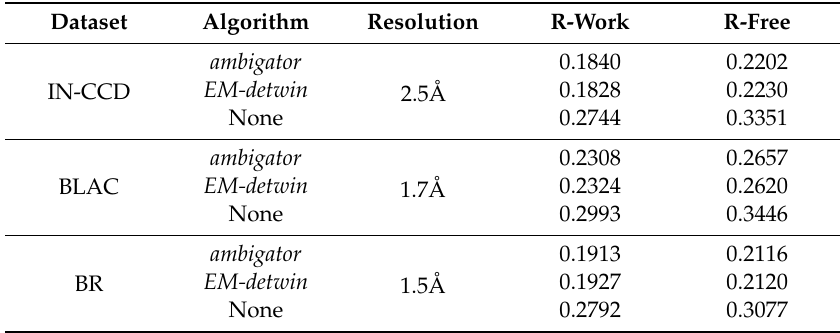
Table 5. Model refinement results from phenix with default